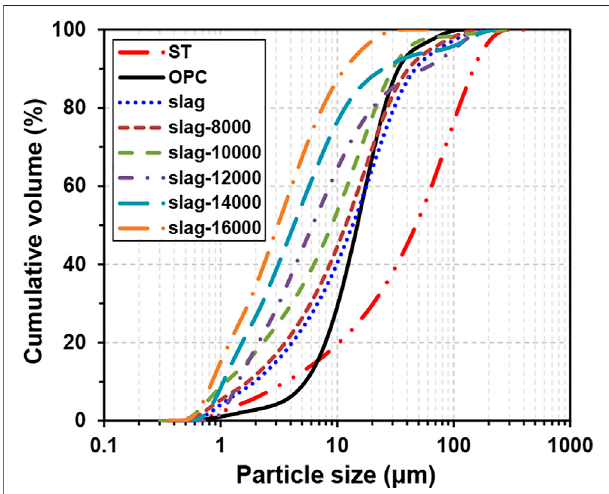
FIGURE 1 | Cumulative GSD curves of the studied materials.